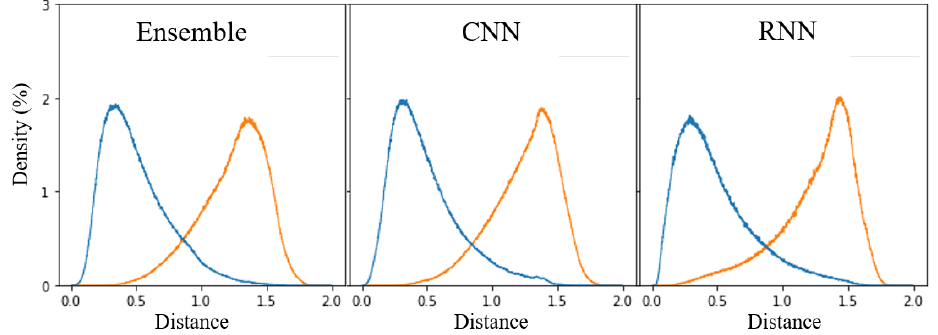
Figure 11. Distributions of distances between homogeneous unit steps and between heterogeneous unit steps in the latent